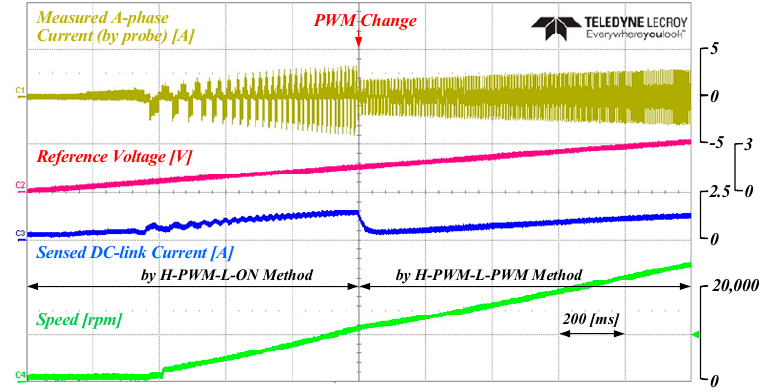
Figure 12. Experimental results on the proposed method.